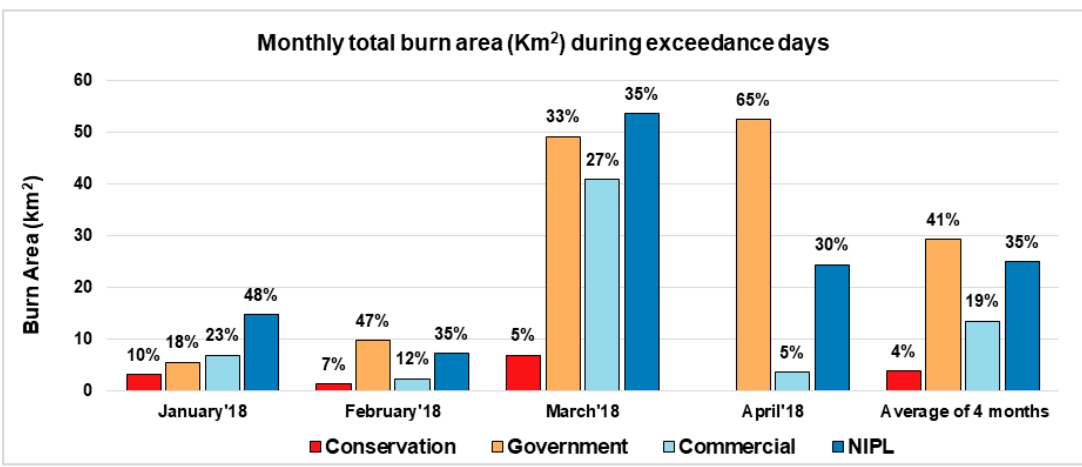
Figure 2. Monthly total burn area (km 2 ) during the days of exceedance. For a specific month, the data label shows the relative percentage from the four landowner categories.